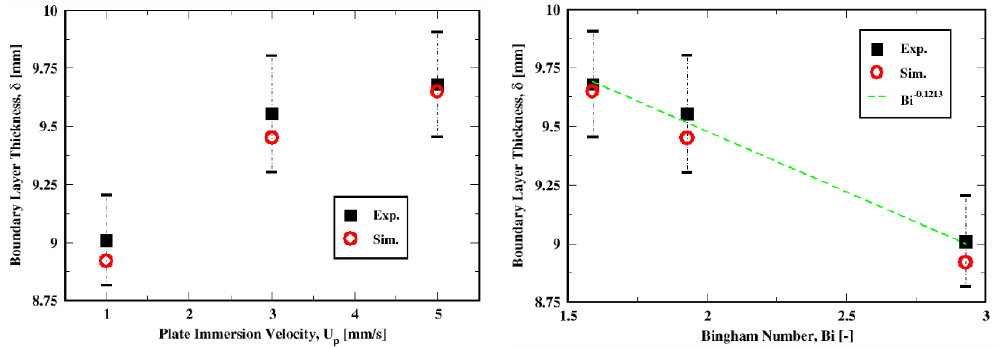
Figure 7. Thickness of the boundary layer with respect to the immersion velocity of the plate ( left ) and the Bingham number ( right ).